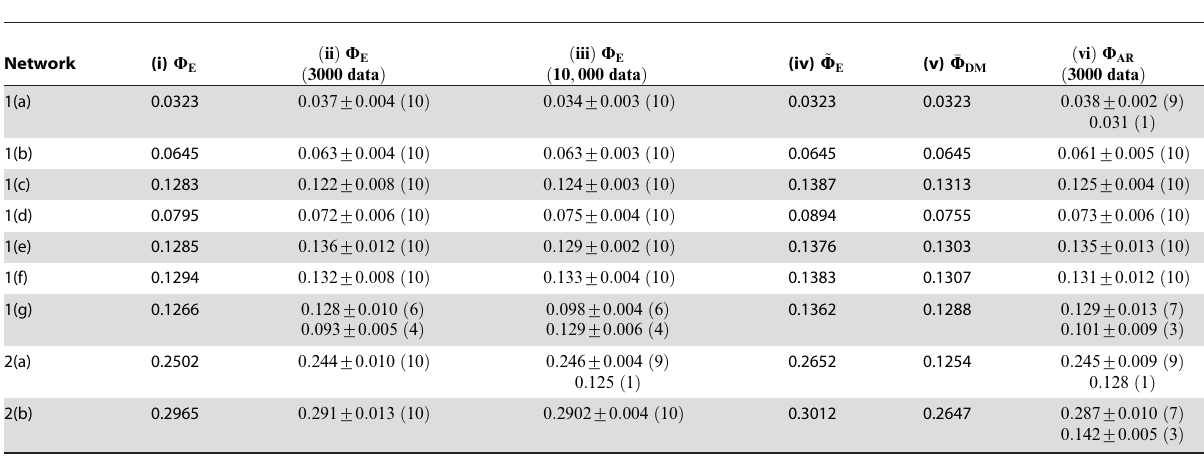
Table 1. Integrated information computed in various ways for the networks shown in Figs. 1 and 2.